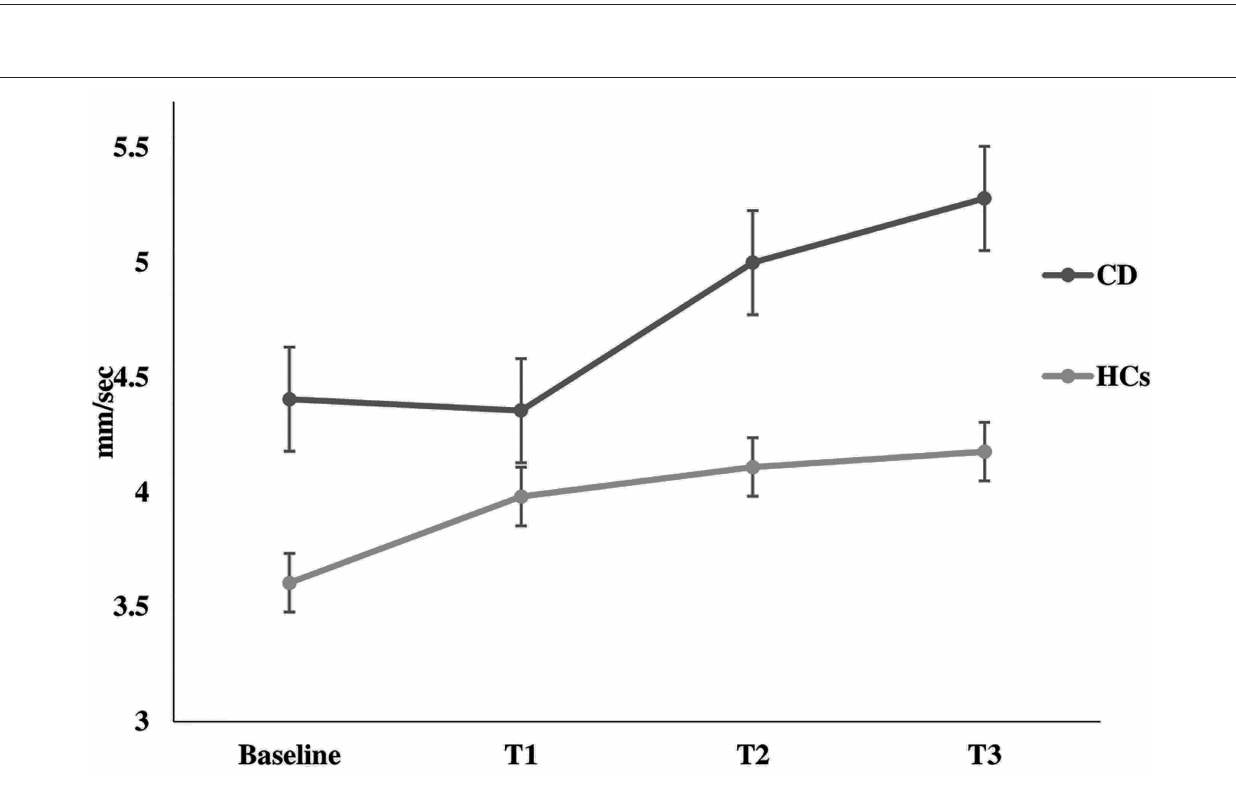
Frontiers in Neurology |